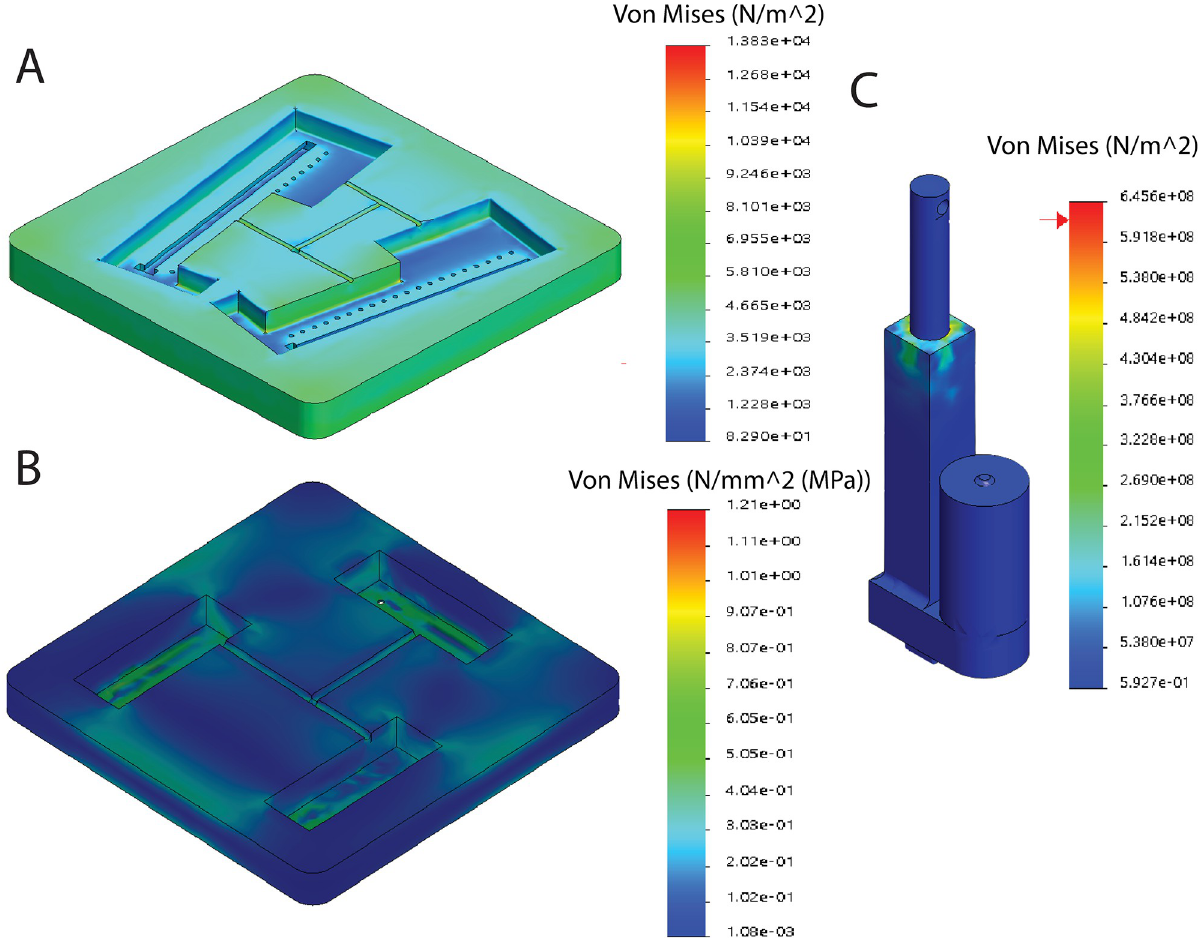
Fig 9. Von Mises result under the static nodal stress for (A) Upper platform, (B) Lower platform, and (C) Linear actuator.